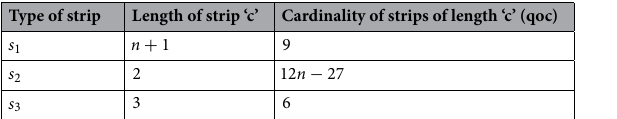
Table 1. Edge partition of ZCS ( l , m , n )